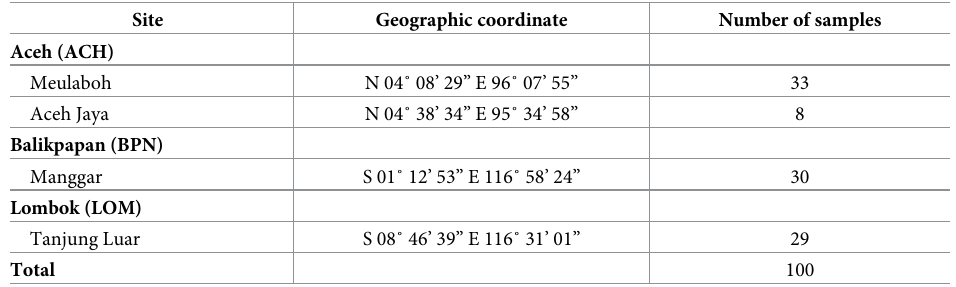
Table 1. Sampling collection sites at major shark landing sites in